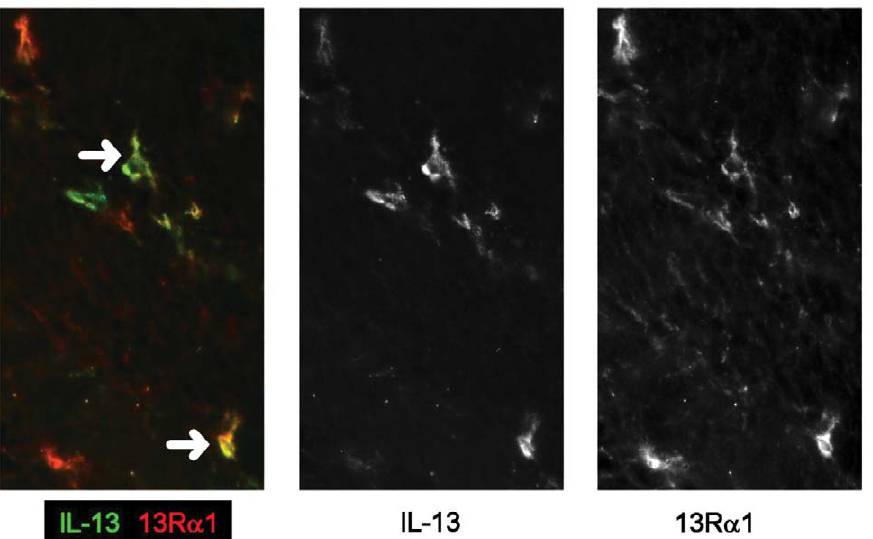
Figure 7. IL-13 is co-localises with IL-13R a 1 in fCD muscle. Double labeling, in frozen fibrotic CD tissue sections, for IL-13 (green) and IL-13R a 1 (red) and split monochrome images ( 6 20).